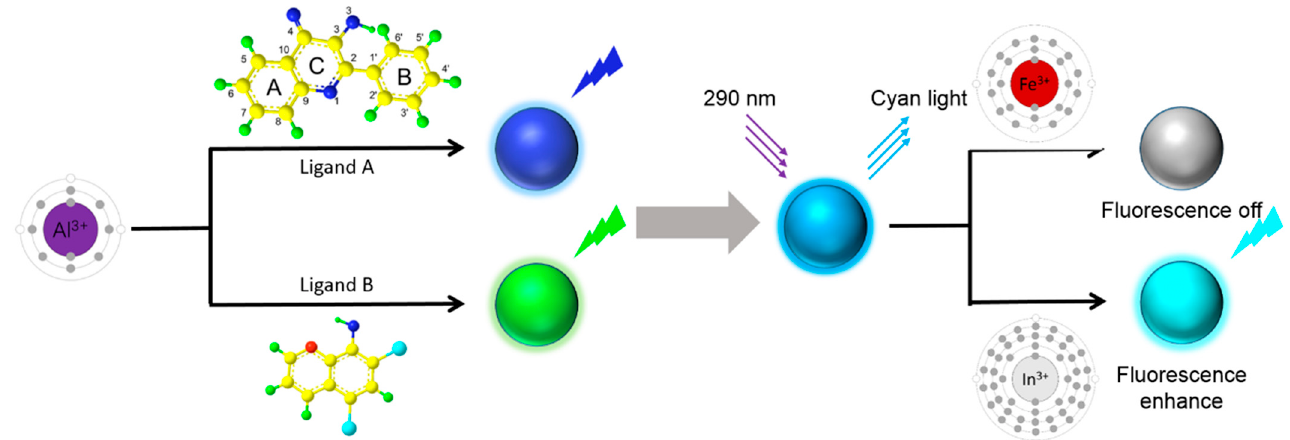
Figure 1. Schematic diagram of the method for tuning the color of cyan light by the combination of blue light and green light, and the sensitivity of CLM to metal ions with both enhancement and quenching effects.